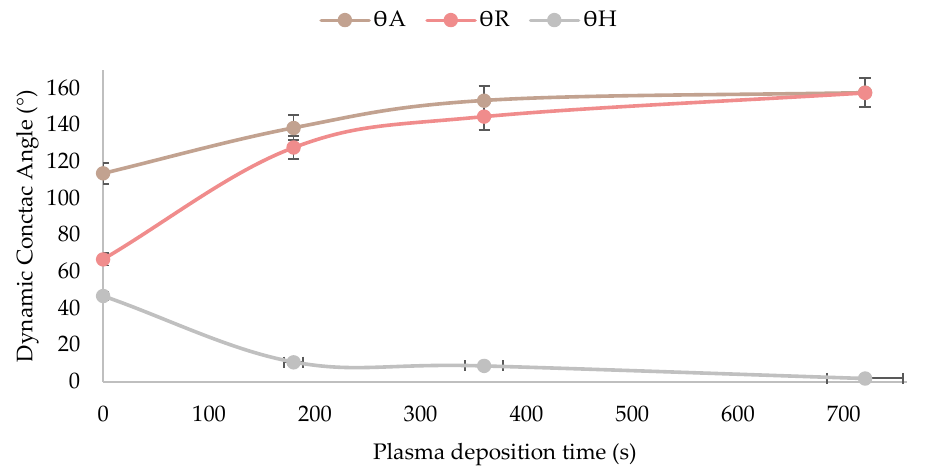
Figure 9. Evolution of the dynamic water contact angles as a function of HMDSO plasma deposition time on leather samples.